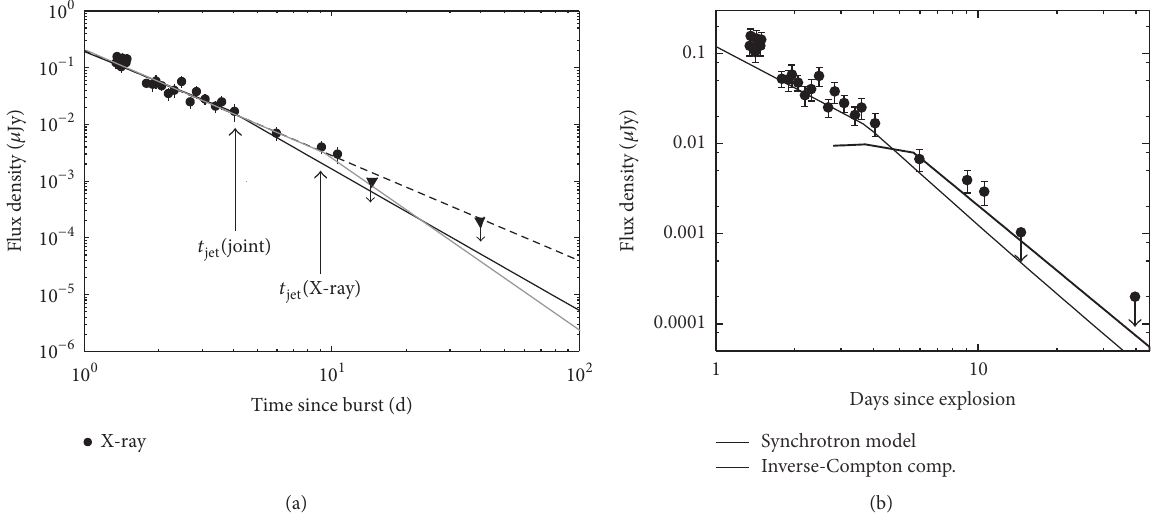
Figure 4: (a) X-ray light curve of GRB 070125. Best-fit single power-law models are shown with dashed lines, while the broken power-law (joint) is the joint fit to optical and X-ray data and grey solid line 𝑡 (X-ray) is the independent fit. The models are shown in solid lines. The 𝑡 jet jet independent fit shifts the jet break to ∼ 9-10 days, which was found to be day 3 for optical bands. (b) Contribution of IC in the synchrotron model for the X-ray light curve of GRB 070125. The thin line represents the broadband model with the synchrotron component only. The thick line represents the IC light curve. One can see that IC effect can delay the jet breaks in X-ray bands